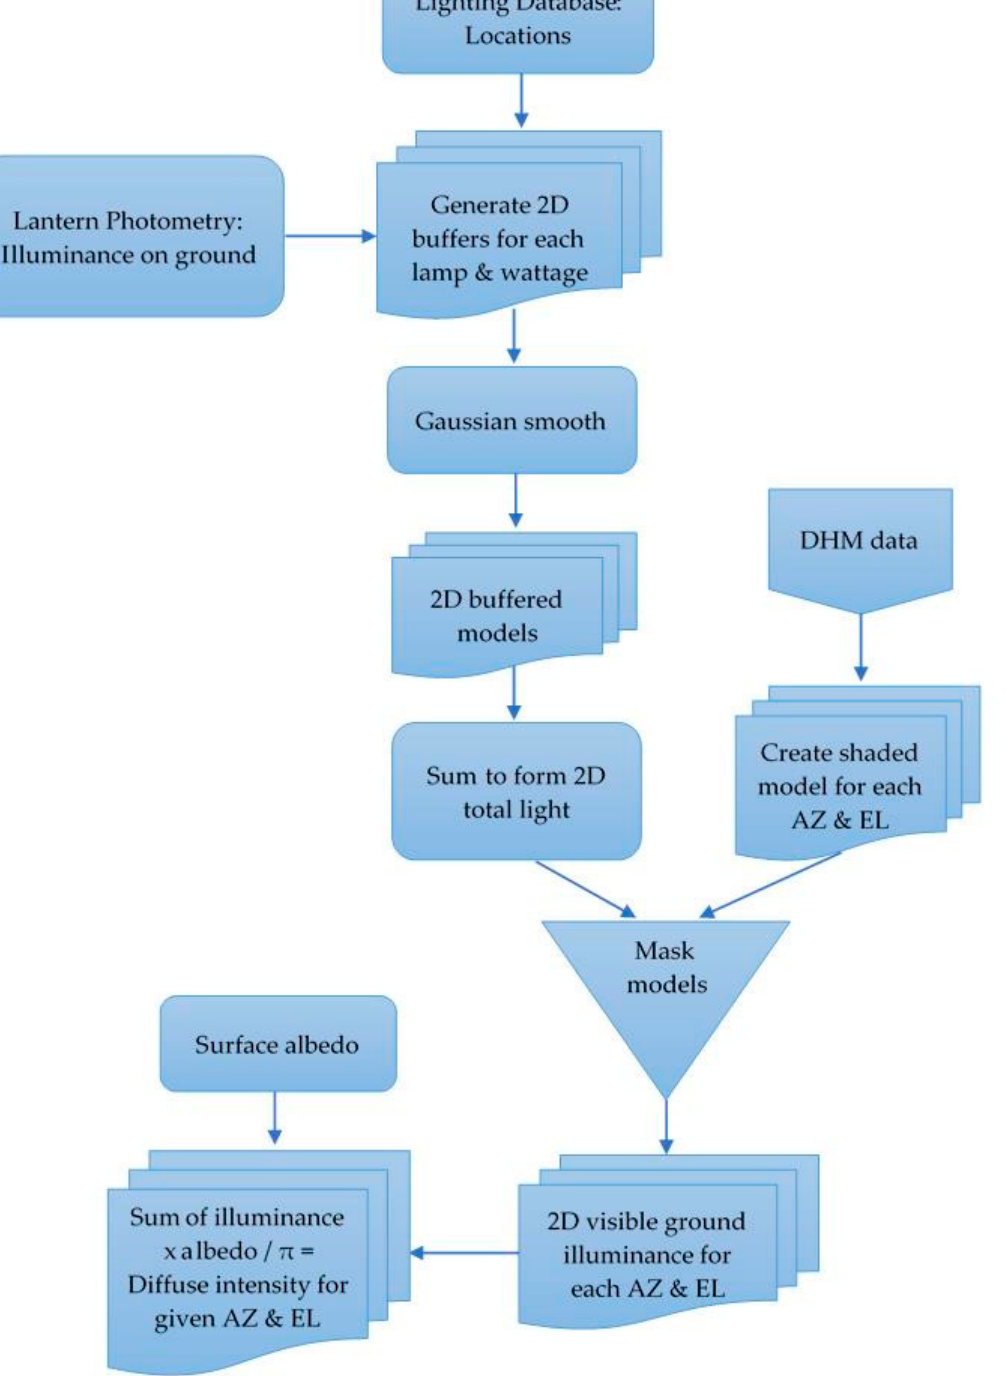
Figure A4. Flowchart of the generation of diffuse emission at each chosen